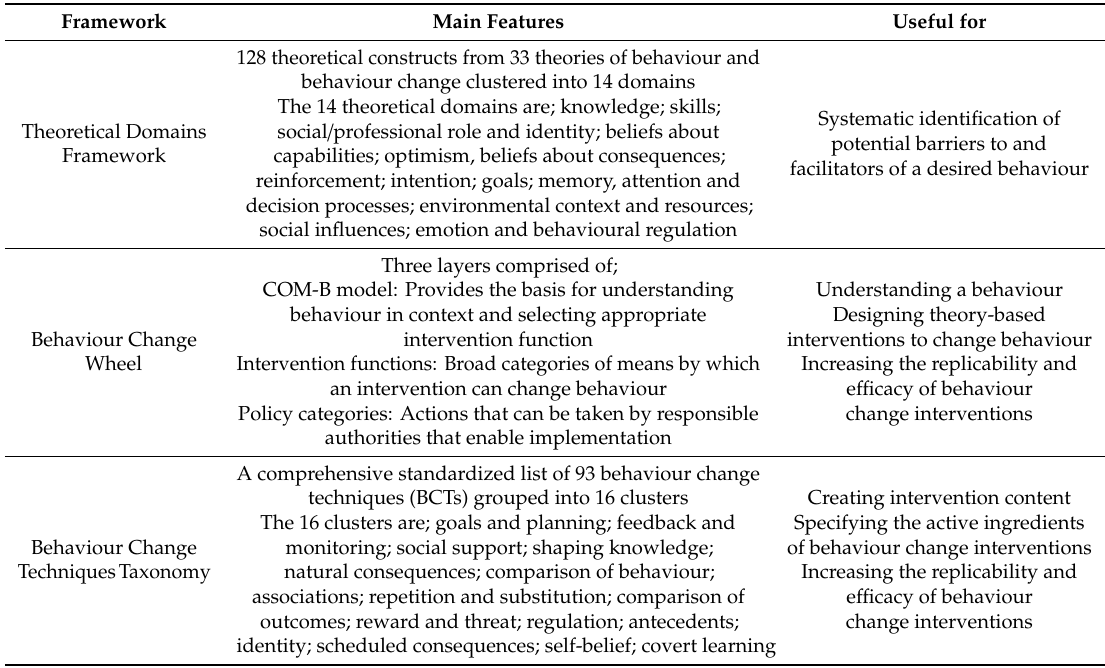
Table 1. A summary of the main features and uses of the Theoretical Domains Framework (TDF)